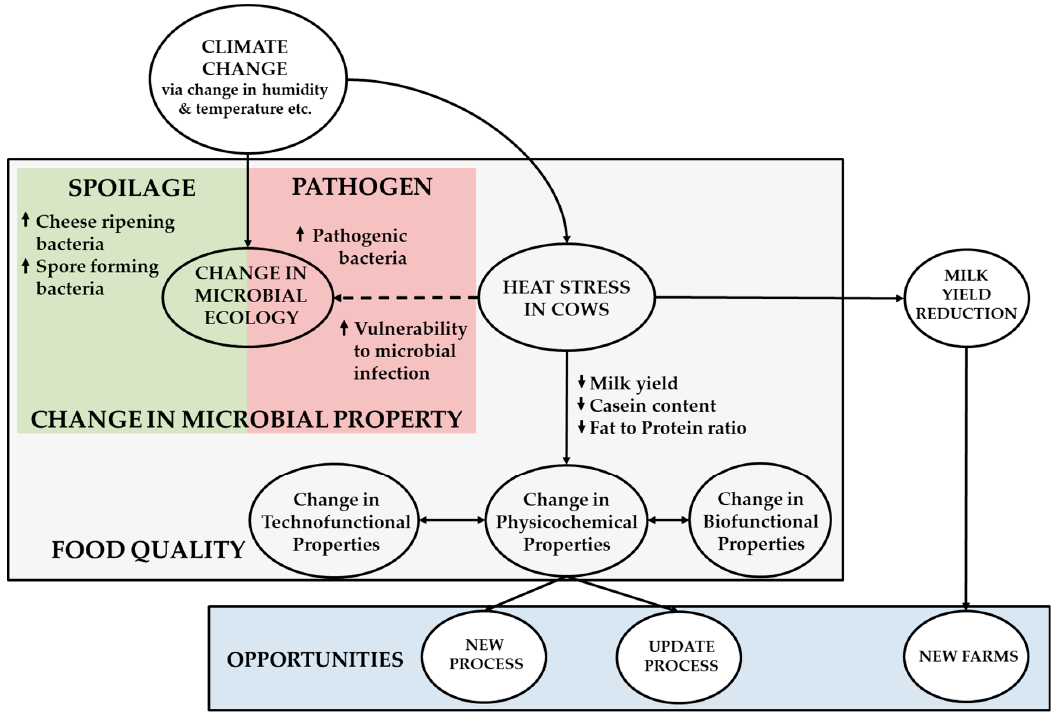
ff ects of climate change on raw Figure 2. The effects of climate change on raw milk. Figure 2. The e